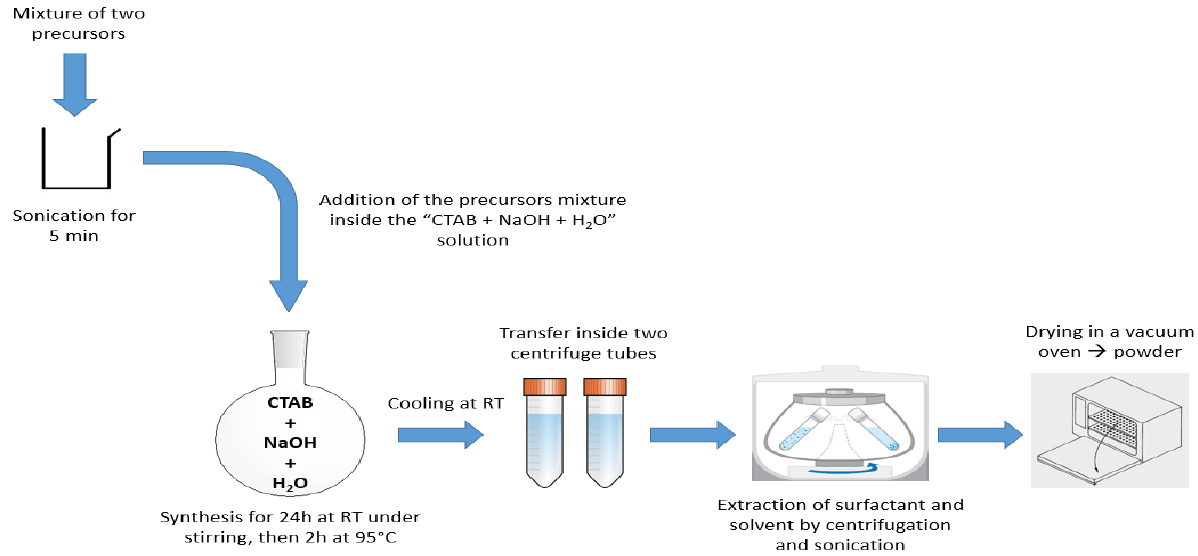
Figure 19. PMO NPs synthesis process with CTAB.